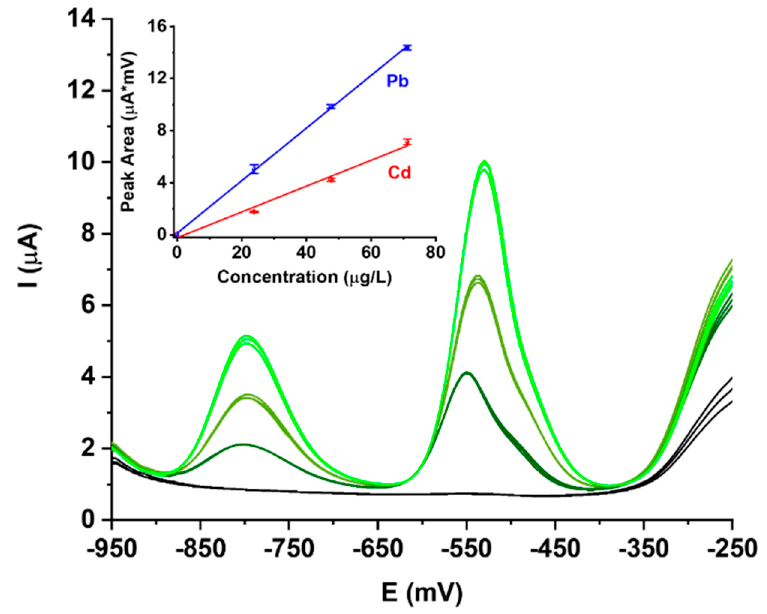
Figure 2. Differential pulse, anodic stripping voltammetry analyses of Cd and Pb solutions, and corresponding calibration curves (inset) at 0, 25, 50 and 75 μ g/L on a working Bi/PO 4 /PSS